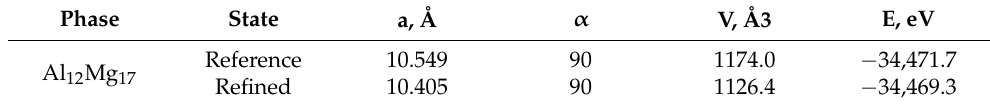
Table 3. Structural parameters of the detected phase in the Al 12 Mg 17 -B powder.